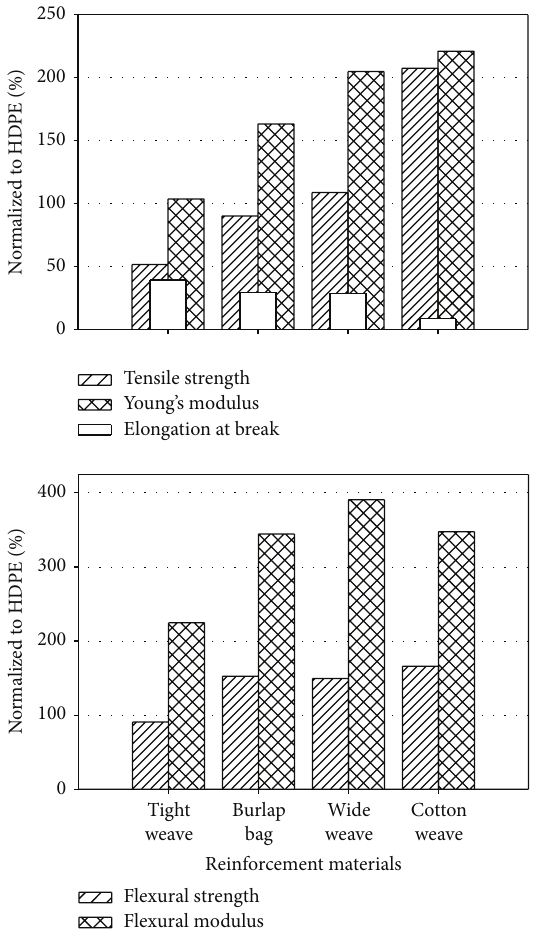
Figure 6: Normalized effect of reinforcement materials on mechan- ical properties of LCs compared to